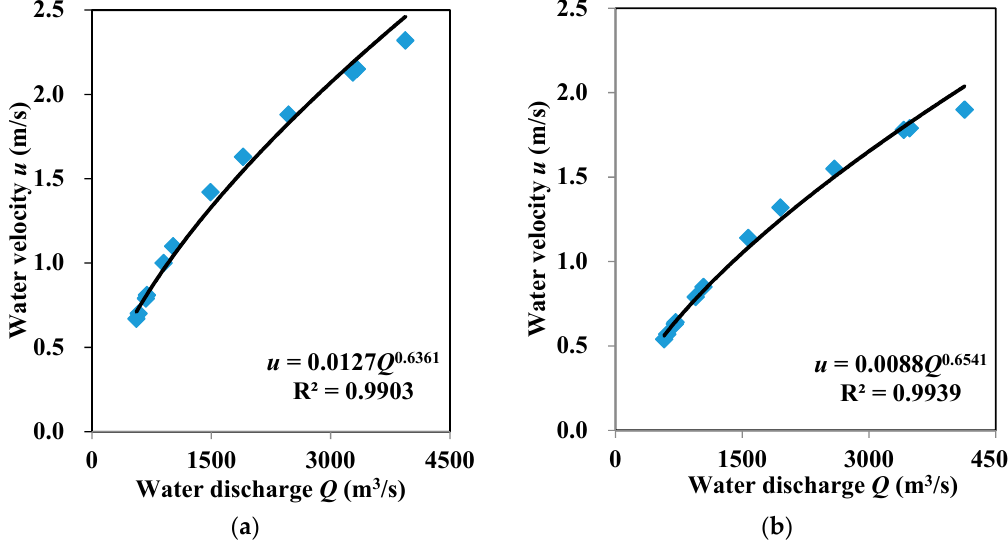
Figure 4. The relationship between water discharge and water level for the upstream ( a ) and Figure4. Therelationshipbetweenwaterdischargeandwaterlevelfortheupstream( a )anddownstream downstream ( b ) of Jinghong reservoir. ( b ) of Jinghong